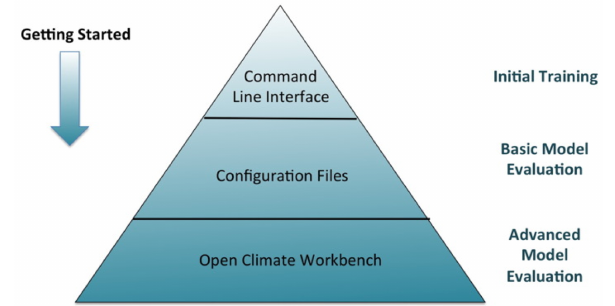
Figure 2. The approach to getting acquainted and using RCMES and OCW (adapted from JPL, 2018a).